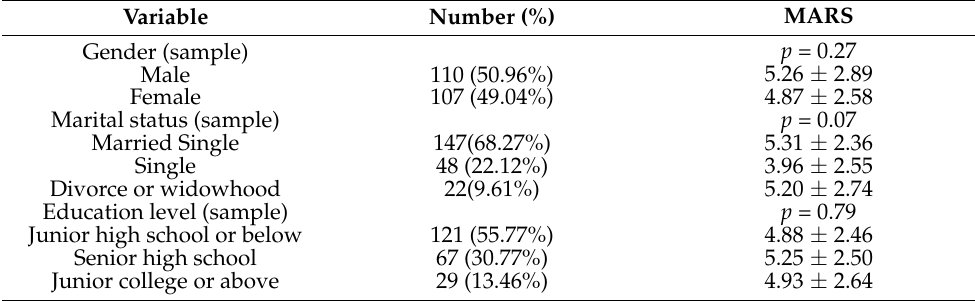
Table 1. Comparison of demographic characteristics and medication adherence of the participants.